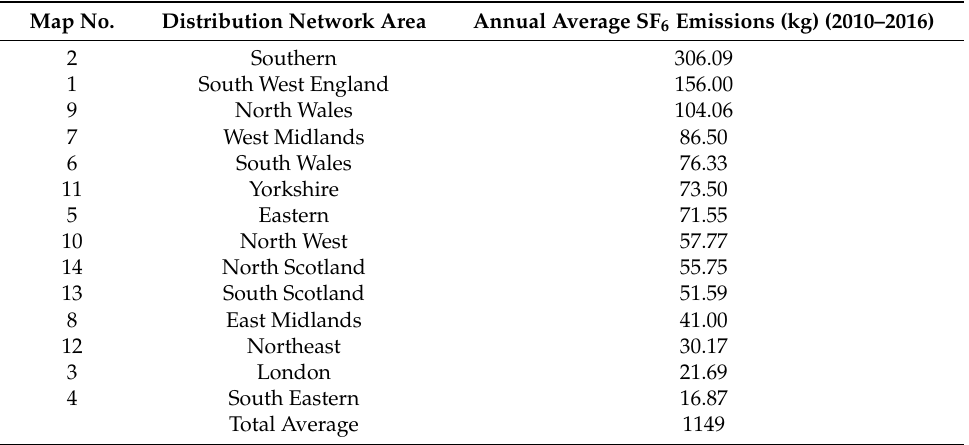
Table 5. Calculated annual average SF 6 emissions (kg) (2010–2016) of the distribution network in Great